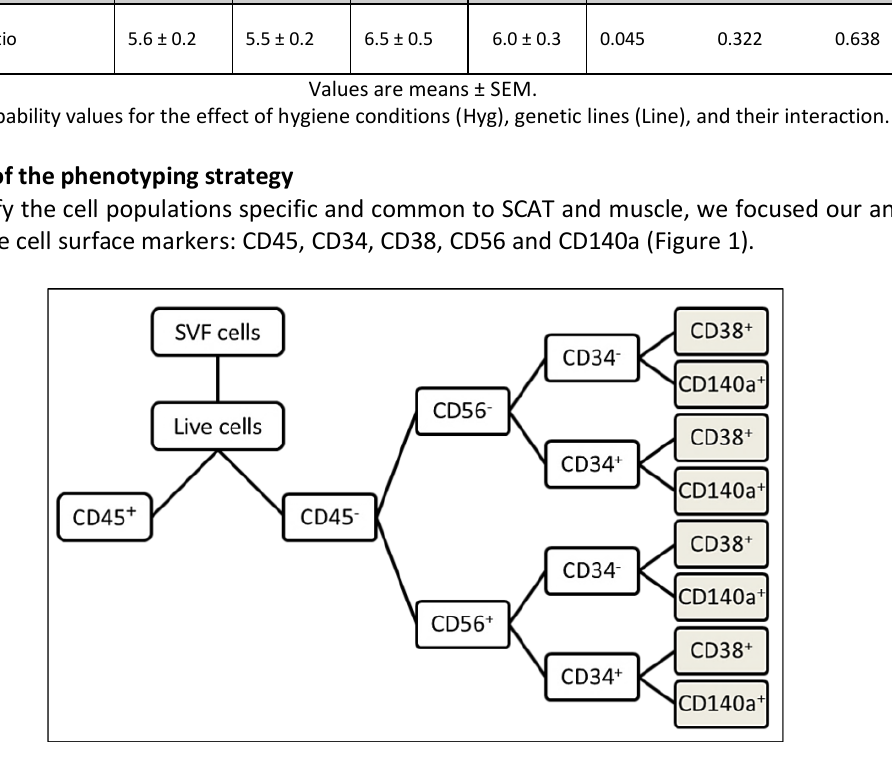
Figure 1. Diagram of the strategy used for cell immunophenotyping by flow cytometry. SVF cells were isolated from adipose tissue and skeletal muscle of growing pigs with low and high residual feed intake and housed in good or poor hygiene conditions for six weeks. A common analytical strategy was used for both tissues. First, live cells were selected from the total SVF cell pool. Then, a first discrimination based on CD45 marker was carried out in order to separate hematopoietic cells (CD45+) from MSCs (CD45-). Then, a phenotyping at the level of four lineage was performed on the MSCs with the CD56, CD34 and CD38 or CD140a (white and brown squares) markers. Adipose tissue was only phenotyped at the level of triple lineage because of its low quantities of CD45-CD56-CD34+ and CD45-CD56+CD34+ cells (white